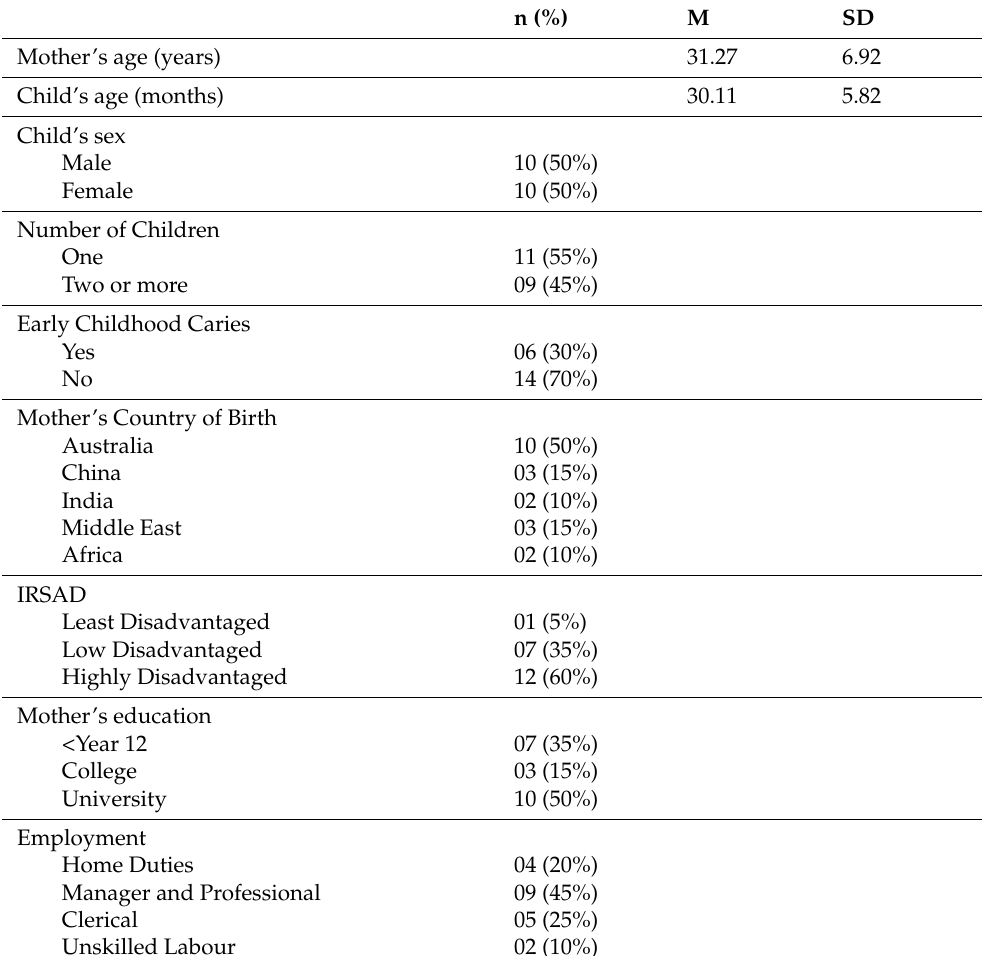
Table 2. Characteristics of the study